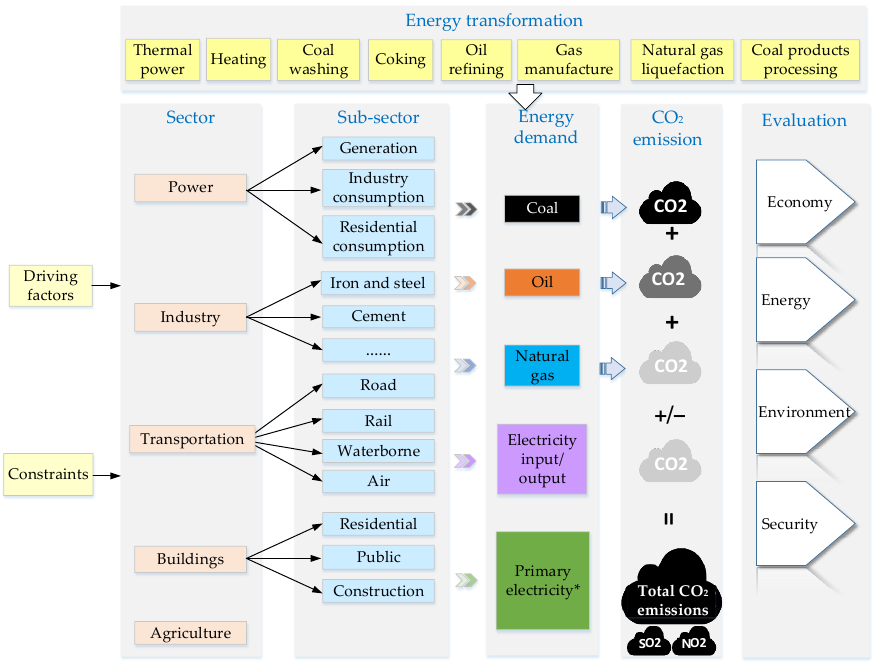
Figure 2. The modeling framework of municipal decarbonization pathway planning.